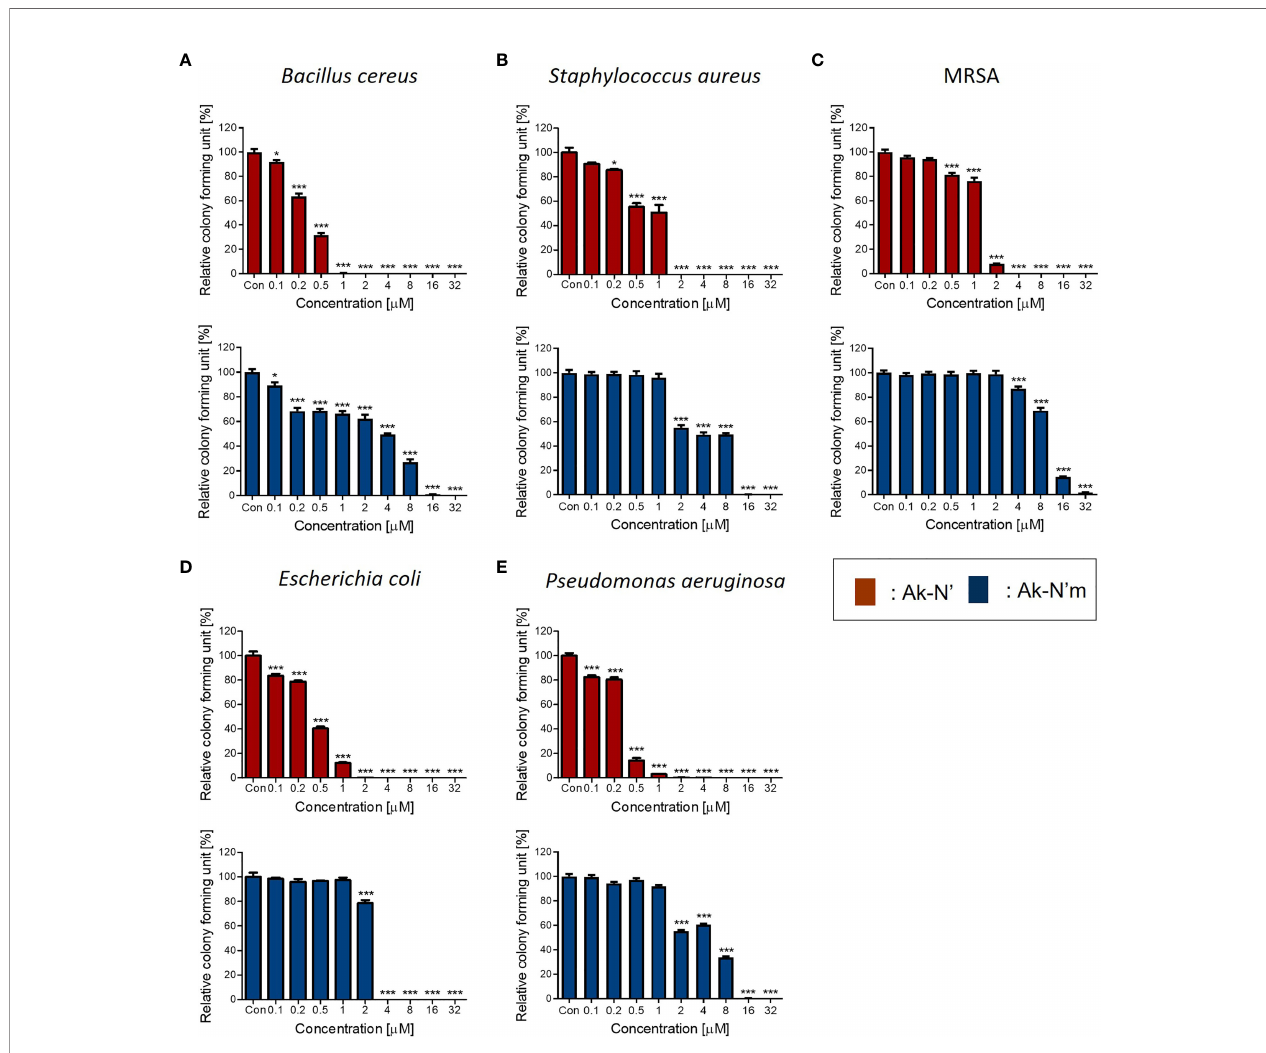
FIGURE 2 | Antibacterial activity of the peptides Ak-N ’ and Ak-N ’ m. Colony forming assay was conducted to validate the antimicrobial effects of the peptides ranging 0.1 m M to 32 m M. Inhibitory effects of Ak-N ’ (red) and Ak-N ’ m (blue) on (A) E . coli , (B) P . aeruginosa , (C) B . cereus , (D) S . aureus , and (E) MRSA were shown. Data are presented as mean ± SEM. *p < 0.05, ***p < 0.001 compared to the control.